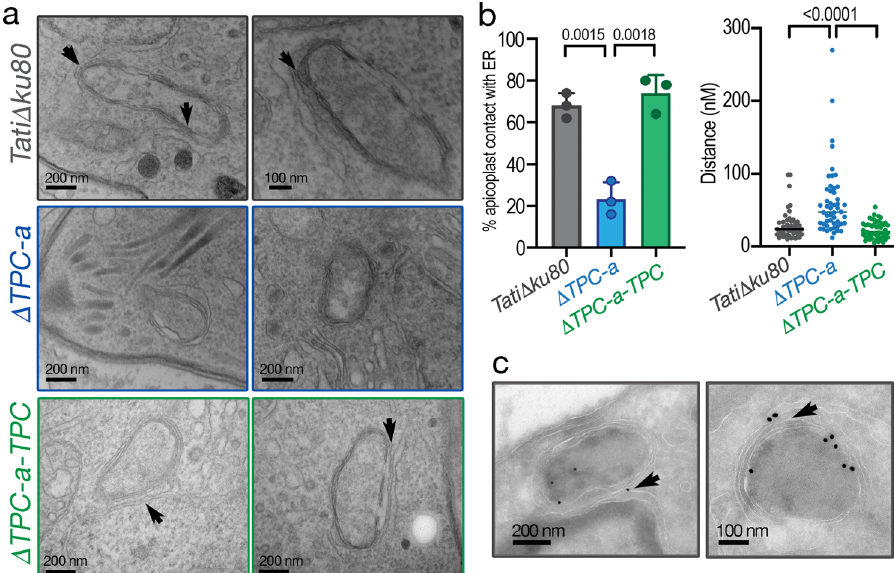
Fig. 8 TgTPC regulates contact site formation between the endoplasmic reticulum and the apicoplast. a Representative ER contact sites in Tati Δ ku80 cells (upper panels). The close contacts are indicated with the small arrows. Middle panels show images from the Δ TPC-a mutants. Lower panels show images of the Δ TPC-a-TPC complemented mutant. b Statistical analyses of the contact sites. The percentage of apicoplasts that are in close contact with the ER ( < 30 nm) in three technical repeats in different days were analyzed for comparison between the three cell lines ( left panel ). Δ TPC-a versus Tati Δ ku80 : p = 0.0015; Δ TPC-a versus Δ TPC-a-TPC p = 0.0018. The ER-apicoplast distance in 50 randomly chosen cells was analyzed ( right panel ). p < 0.0001. Data are presented as mean ± SD. Student ’ s t test. p value: unpaired two tailed t test performed in all comparisons. c Immuno-EM of